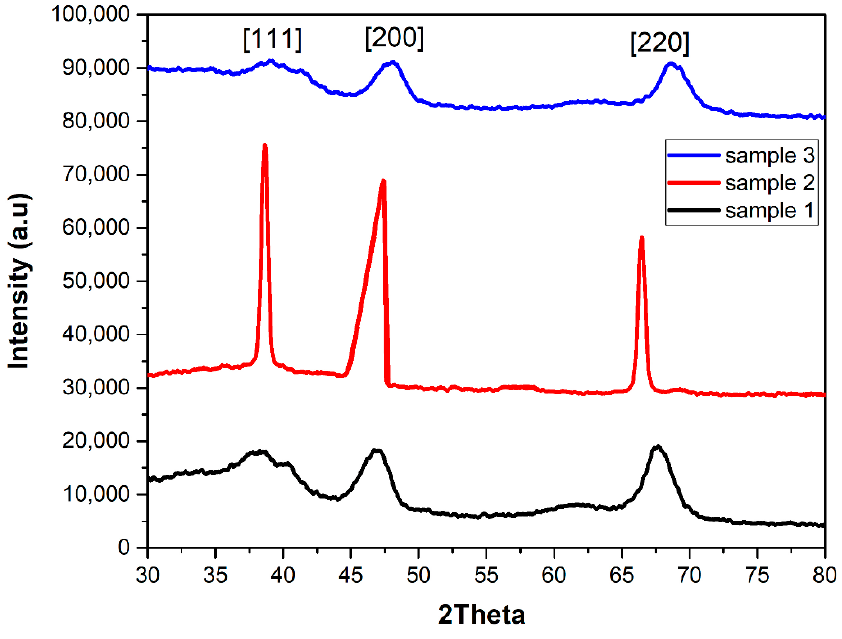
Figure 7. XRD spectra of AuNRs produced with 3 mL, 4 mL and 5 mL of AgNO 3 solution.